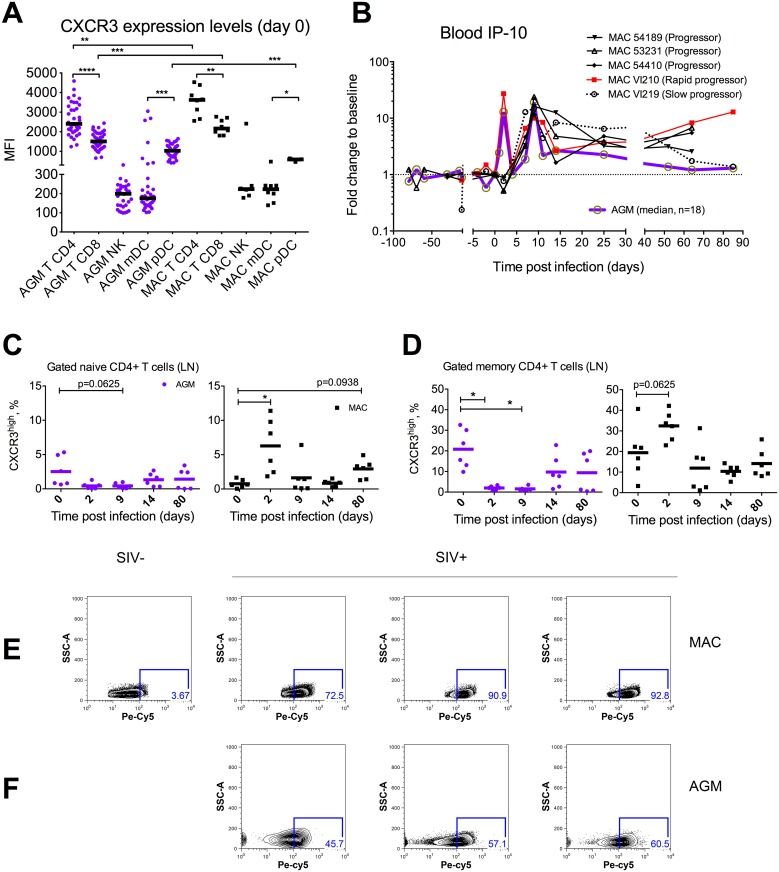
Dynamics of CXCR3+ T-cells and blood IP-10 levels during pathogenic and non-pathogenic SIV infections.
A. CXCR3 expression levels as mean intensity of fluorescence (MIF) in rhesus macaques (n = 8) and AGM (n = 18) peripheral blood cell subsets before SIV inoculation. B. Blood IP-10 dynamics in 5 rhesus macaques versus AGMs (n = 18, median is shown here) IP-10 levels in plasma were determined in a longitudinal study, before infection and after SIVmac251 or SIVagm.sab92018 challenge in macaques or in AGMs, respectively. IP-10 values are expressed as the fold change from baseline (median of 3 to 4 values obtained before infection). (C-F). CXCR3 expression dynamics from SIVmac infected cynomolgus macaques (n = 3–6) and from SIVagm-infected AGMs (n = 3–6) C. Dynamics of CXCR3 expression in LN naïve CD4+ T cells upon SIV infection. D. Dynamics of CXCR3 expression in LN memory CD4+ T cells upon SIV infection. (E-F). Flow cytometry analysis of internalization levels of CXCR3 in lymph node CD4 T cells in cynomolgus macaques (n = 4) and in African green monkeys (n = 3). Plots of scatter measurements and CXCR3 staining are shown here. Each plot represents an animal.